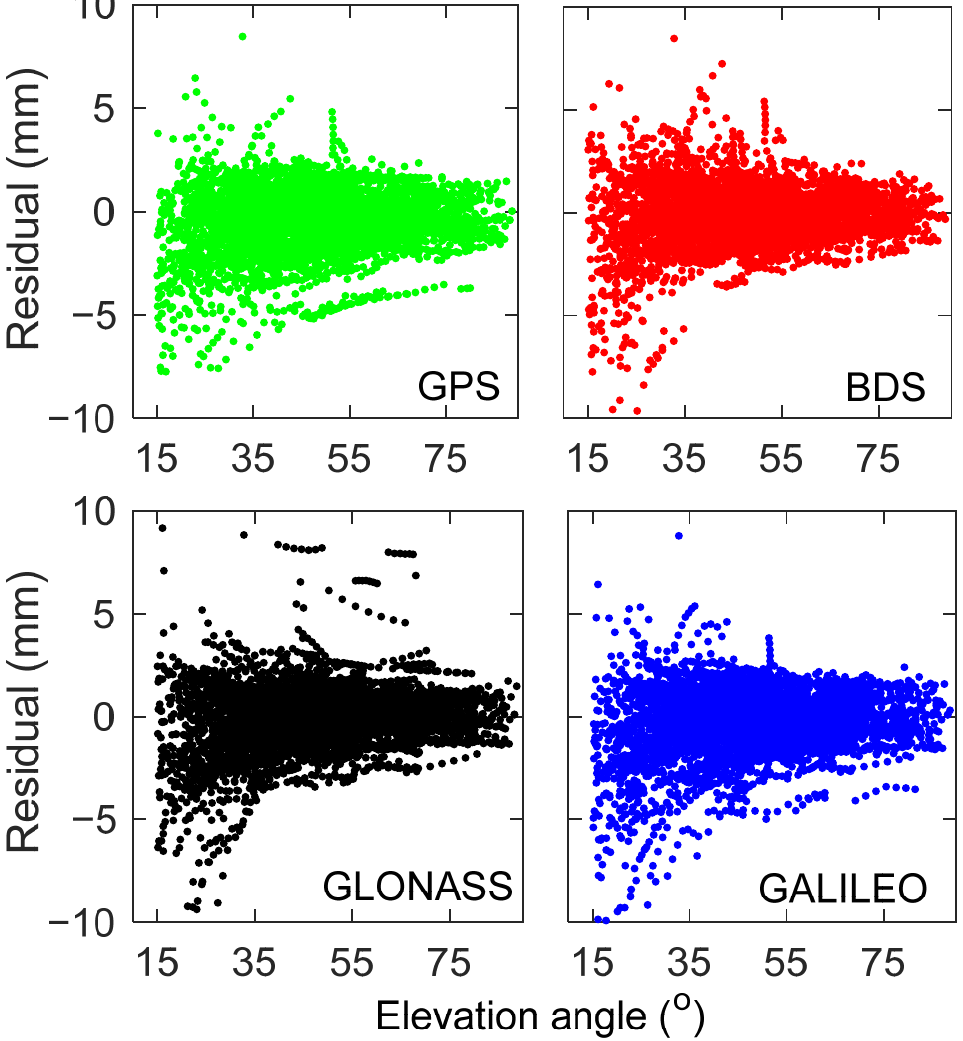
Figure 6. Scatter diagram of the change of SWV residuals with elevation angle for the four satel- lite